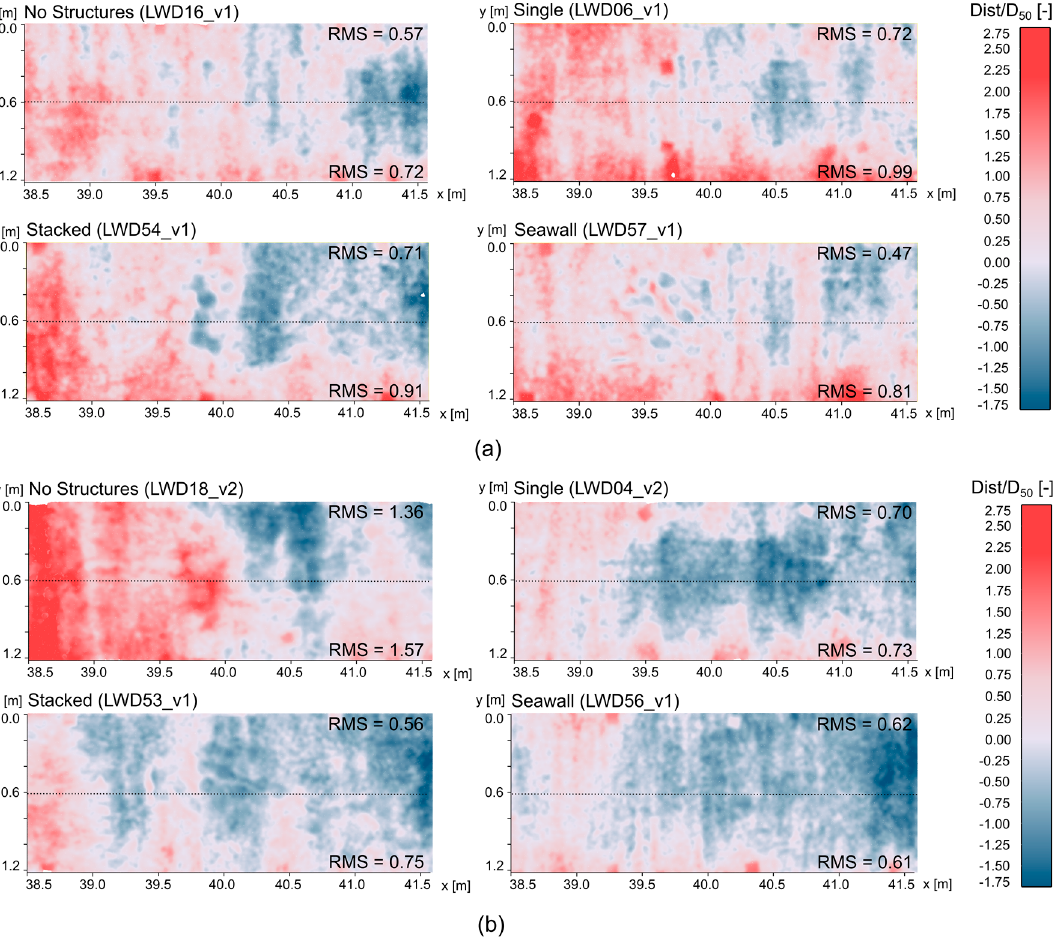
Figure 5. Non-dimensionalized distance between initial gravel surface and ideal 1:8 sloping plane in relation to mean sediment diameter (D 50 = 7.9 mm) for x = 38.5–41.58 m under ( a ) medium wave conditions with T p = 2.17 s, H s = 0.15 m and ( b ) large wave conditions with T p = 2.51 s, H s = 0.20 m.